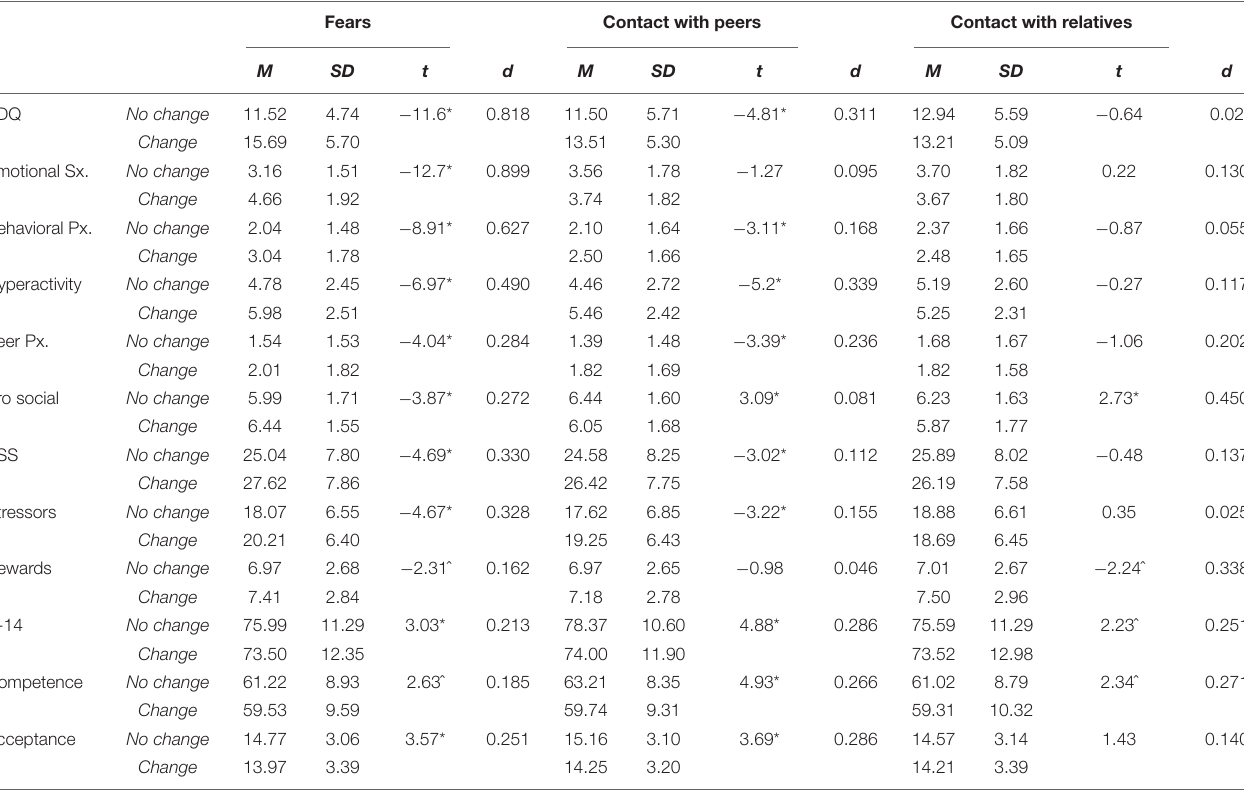
TABLE 5b | Mean scores, standard deviation and Student t to evaluate the differences in the variables according to the perception of habit change in the children (cont.). Fears Contact with